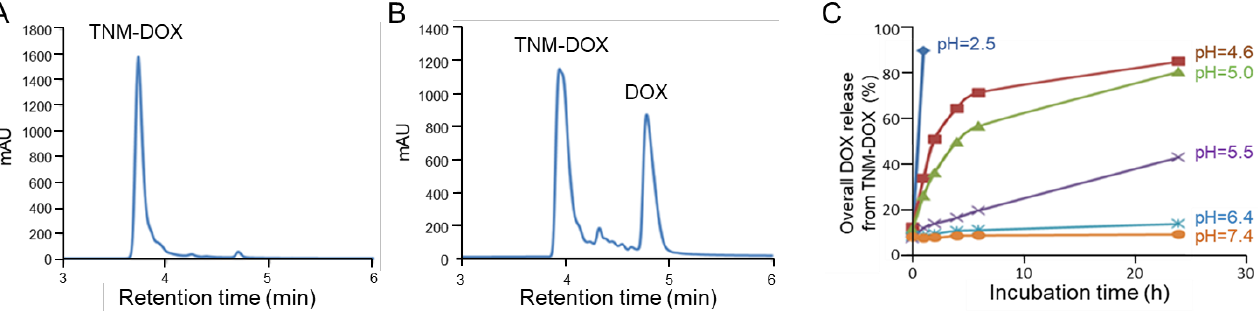
Figure 3. Free DOX release from TNM-DOX. ( A ) HPLC analysis of synthetic TNM-DOX. ( B ) HPLC analysis of free DOX release (in milli absorbance units, mAU) from TNM-DOX over time. ( C ) Time course of free DOX release from TNM-DOX under different pH conditions. Release of free DOX at 1, 2, 4, 6, and 24 h post-incubation in buffers at different pH as indicated.